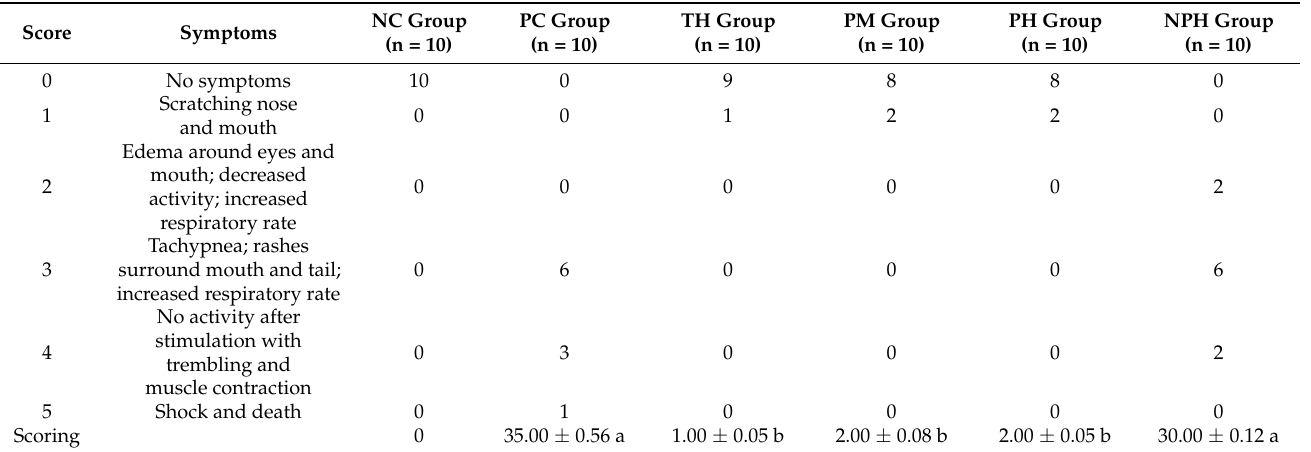
Table 2. Clinical symptoms and scores for each group of